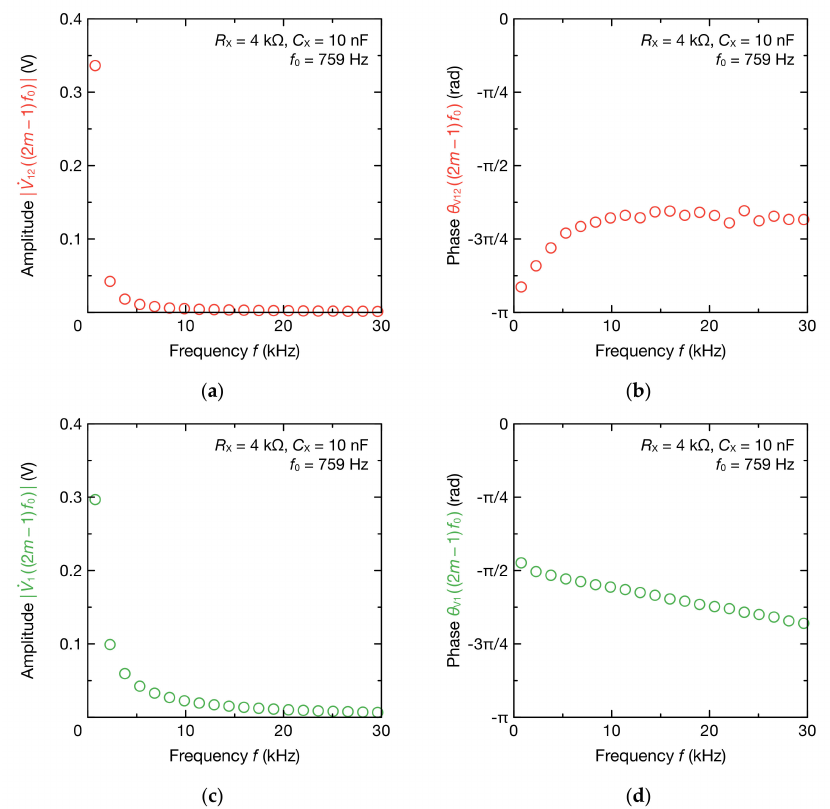
(cid:12) (cid:12) . (cid:12) (cid:12) θ (cid:12) (cid:12) V 12 (cid:12) (cid:12) ; ( b ) phase V12 ; ( c ) amplitude